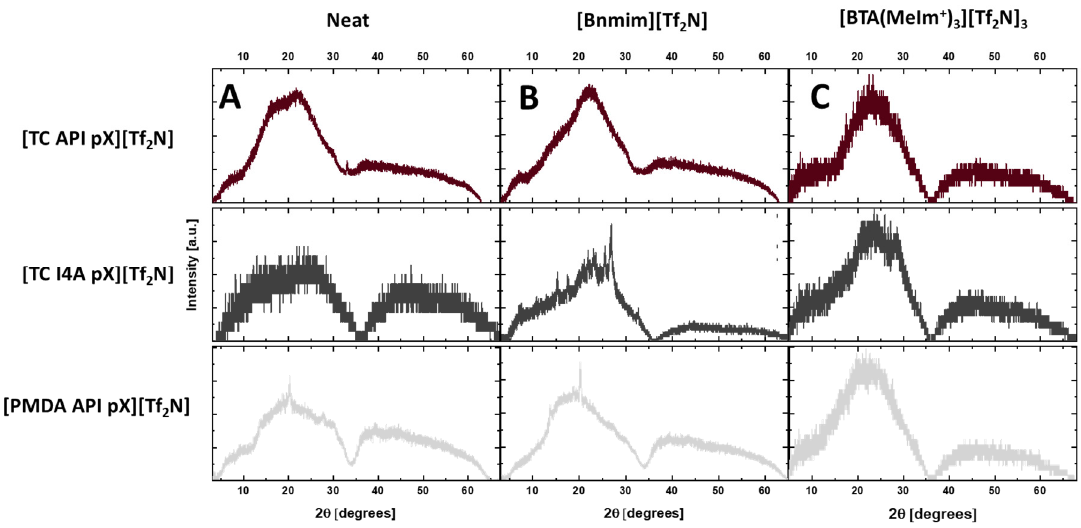
Figure 4. XRD profiles comparing all xylyl ionenes ( A ) neat, ( B ) with 2 equivalents of [Bnmim][Tf 2 N], and ( C ) containing stoichiometric equivalents of [BTA(MeIm + ) 3 ][Tf 2 N − ] 3 .